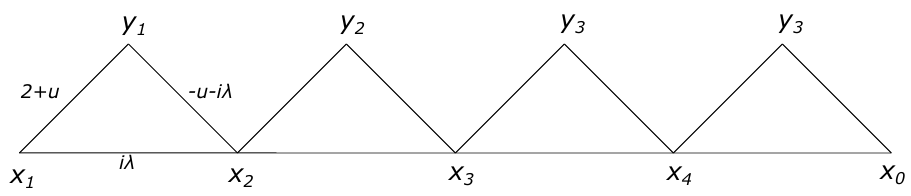
Figure 6 . Graphical representation of the kernel Q ( x 1 , . . . , x N , x 0 | y 1 , . . . , y N ; u ) of the operator Q ( u ) for the size N = 4 . The lines are functions 1 /x 2 to the power written aside; integration points y k are marked by black dots and external points x k are marked by grey